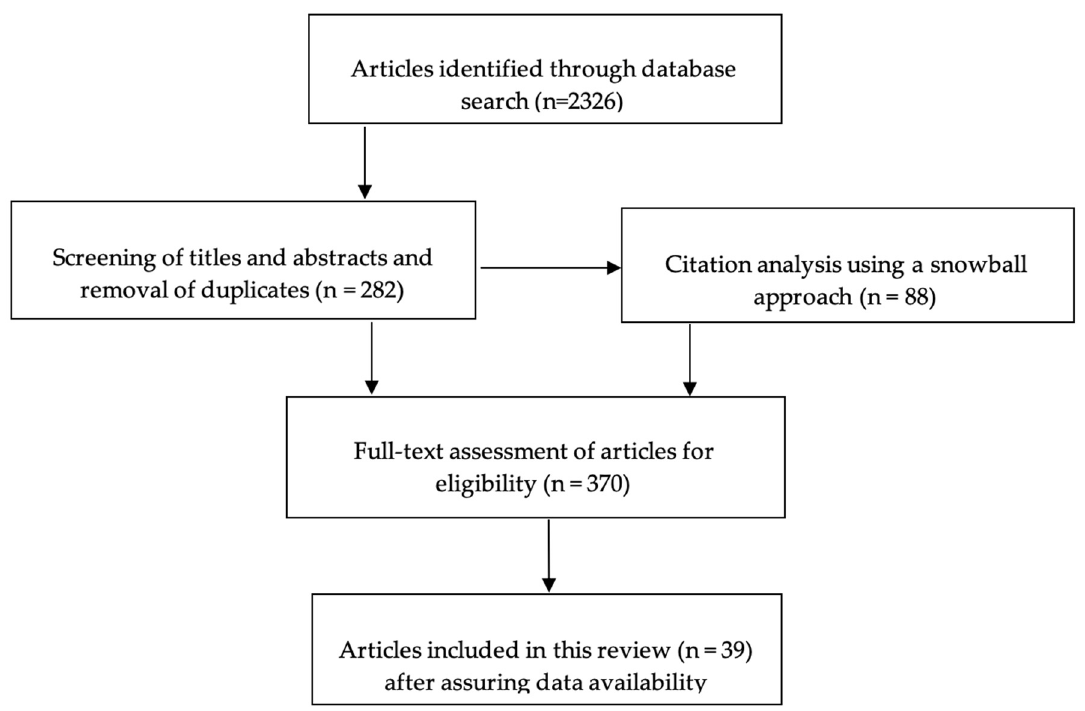
Figure 1. Literature selection process.